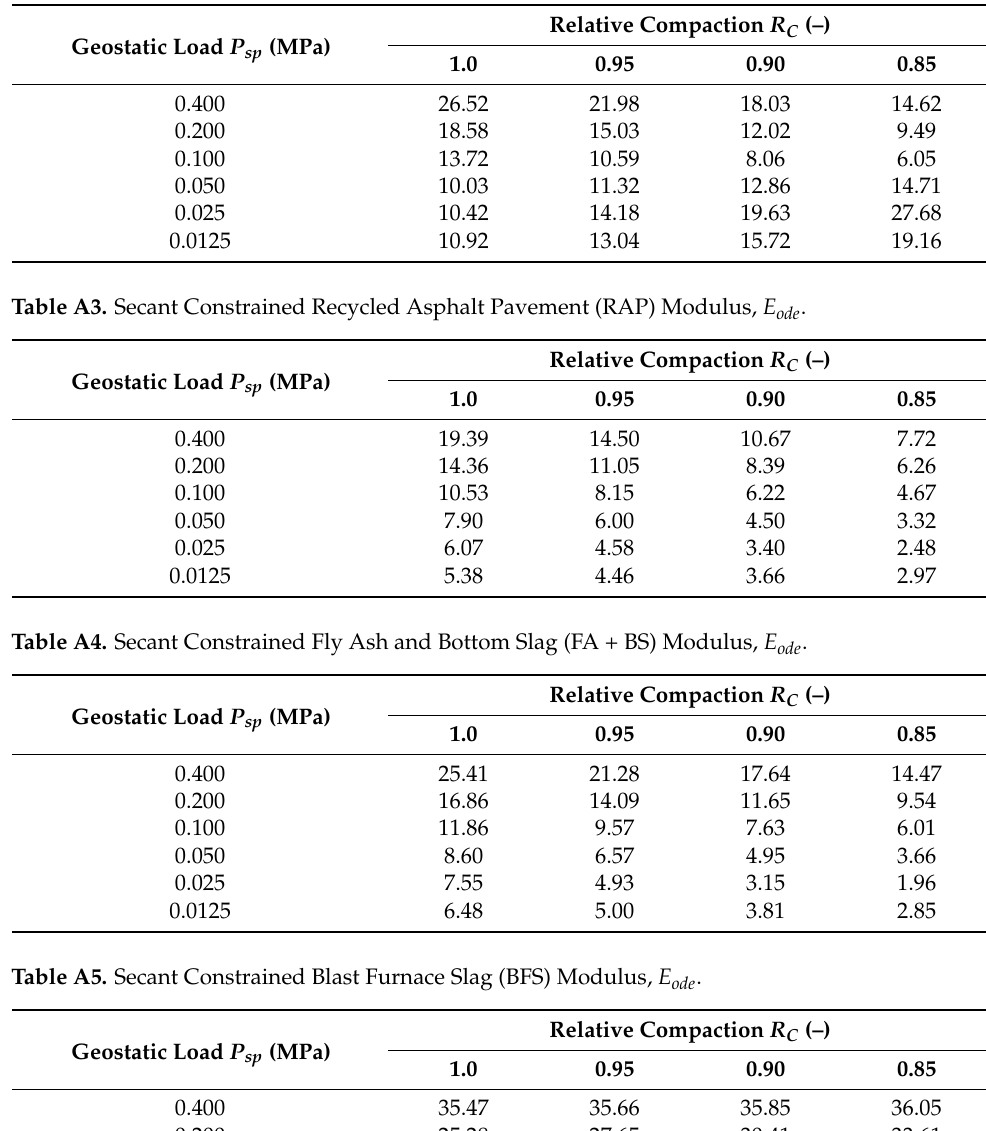
Table A2. Secant Constrained Crushed Brick (CB) Modulus, E ode .